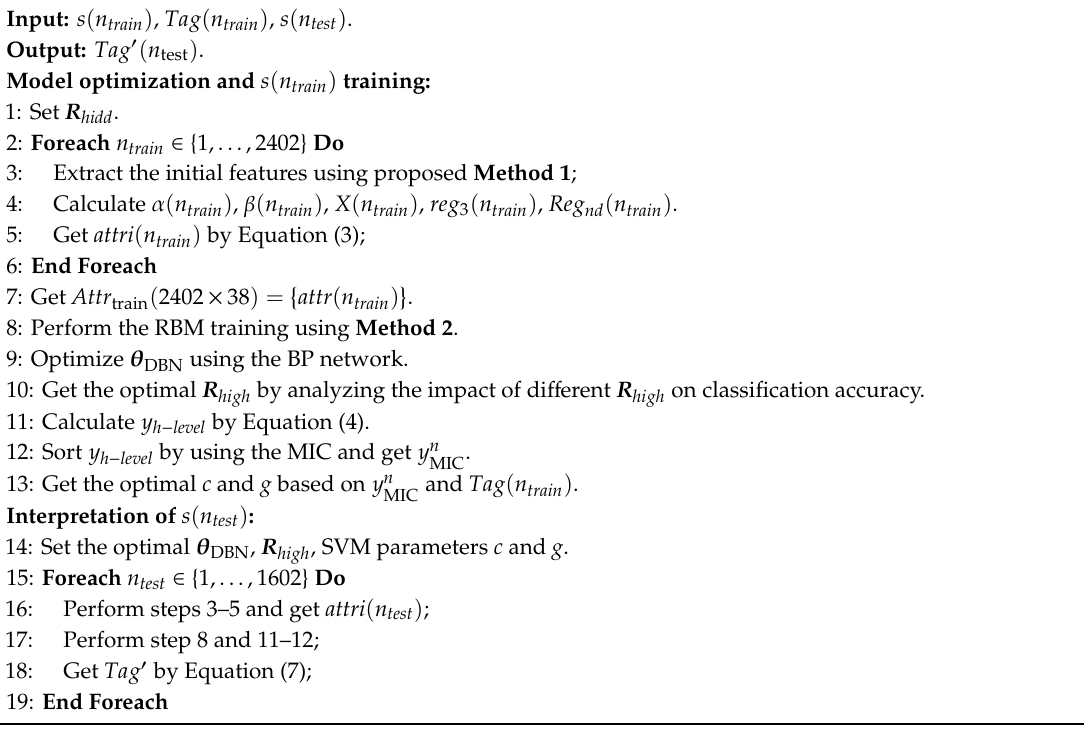
Algorithm 3. MFE-DMIC model